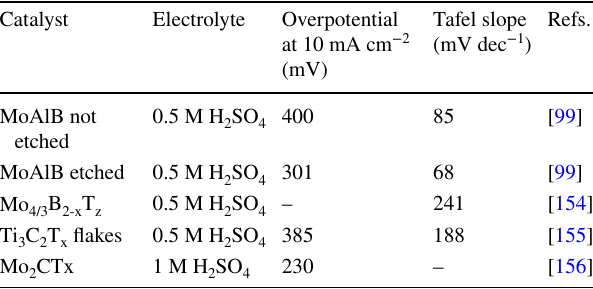
Table 4 Summary of MBenes and MXenes HER electrocatalysts from recent reports Catalyst